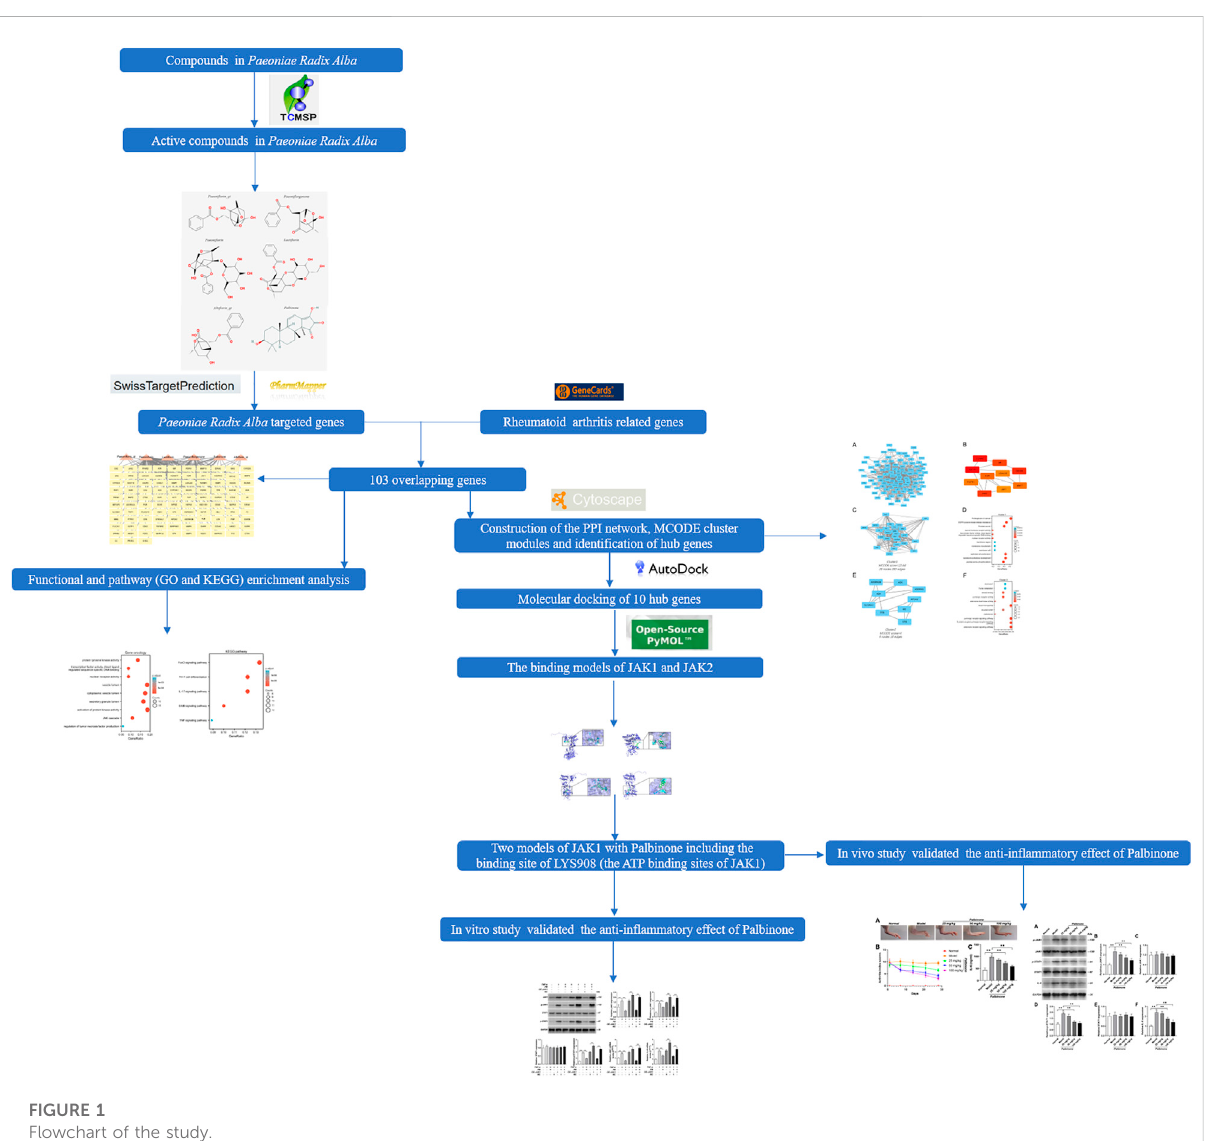
FIGURE 1 Flowchart of the